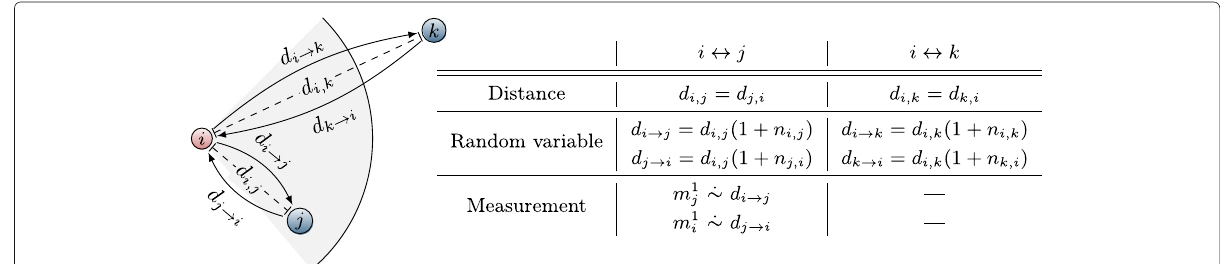
Fig. 2 Illustration of the notation and the effects of the transmit ambiguities. Considered here are an agent i , which is assumed to use ID I R ( red ), and two surrounding agents (using ID I B ( blue )), of which one is within the communication range of i . Also illustrated are the actual distances between i and the other two agents and the RVs that describe potential measurements of those distances. For both cases, the table given on the right-hand side clarifies the notation and the fact that no measurement of the distance between i and k has been made. Here, m ˙∼ d is used to denote that measurement m is a single realization, i.e., a sample, of the distribution